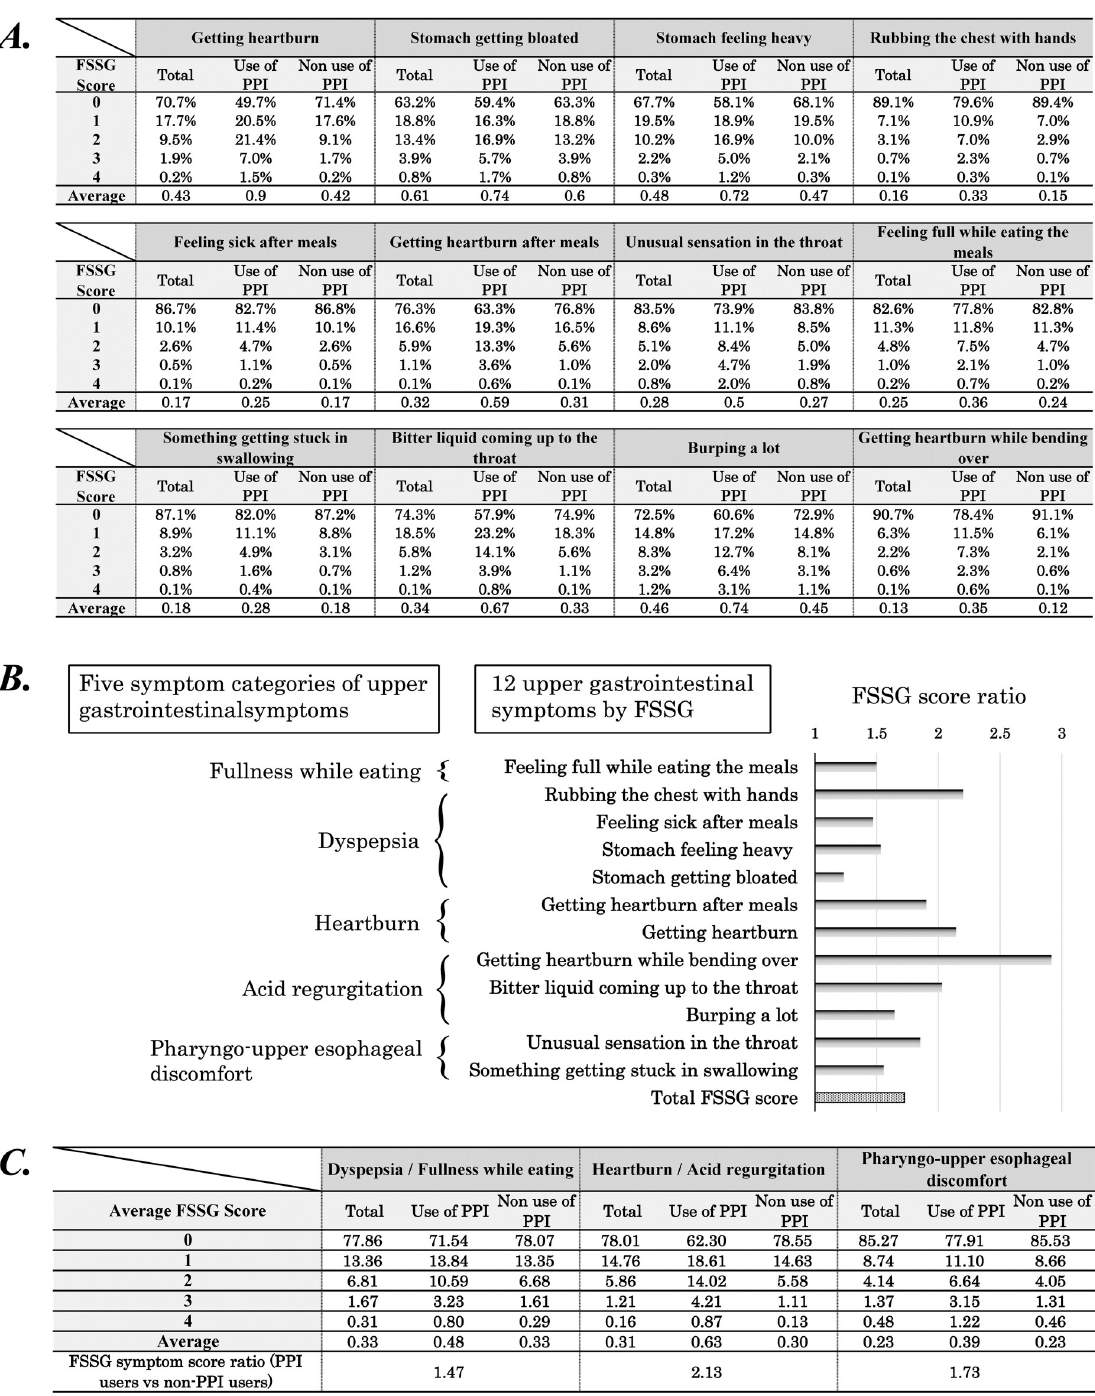
PLOS ONE | https://doi.org/10.1371/journal.pone.0270252 June 17,